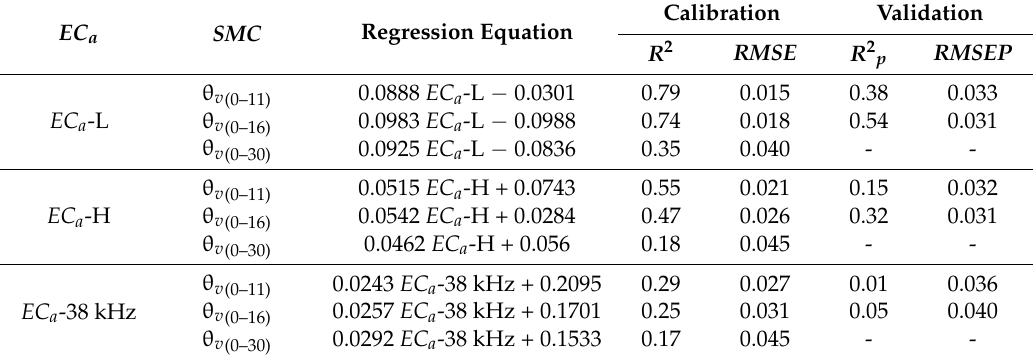
Table 4. Linear regressions between EC a data from CMD-MINIEXPLORER and GEM-2 with TDR measured SMC for different integral depths ( n = 20).